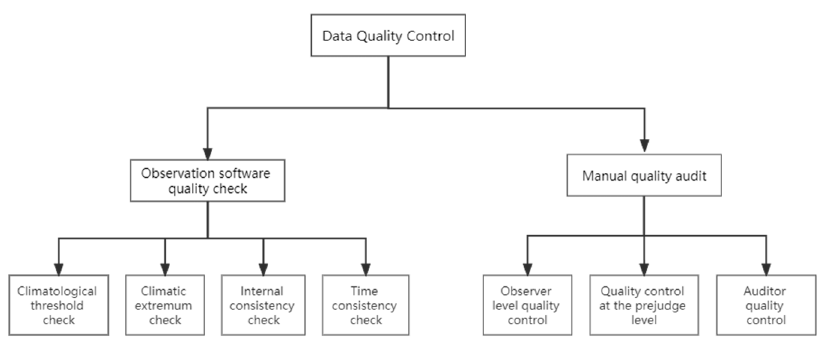
Figure 2. Data quality control flow chart.